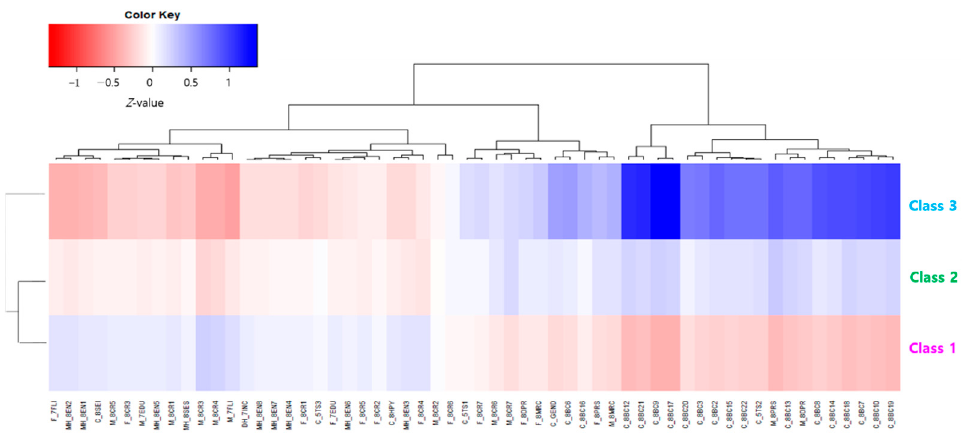
Figure 3. Differences of predictor’s z-values between EFD trajectory